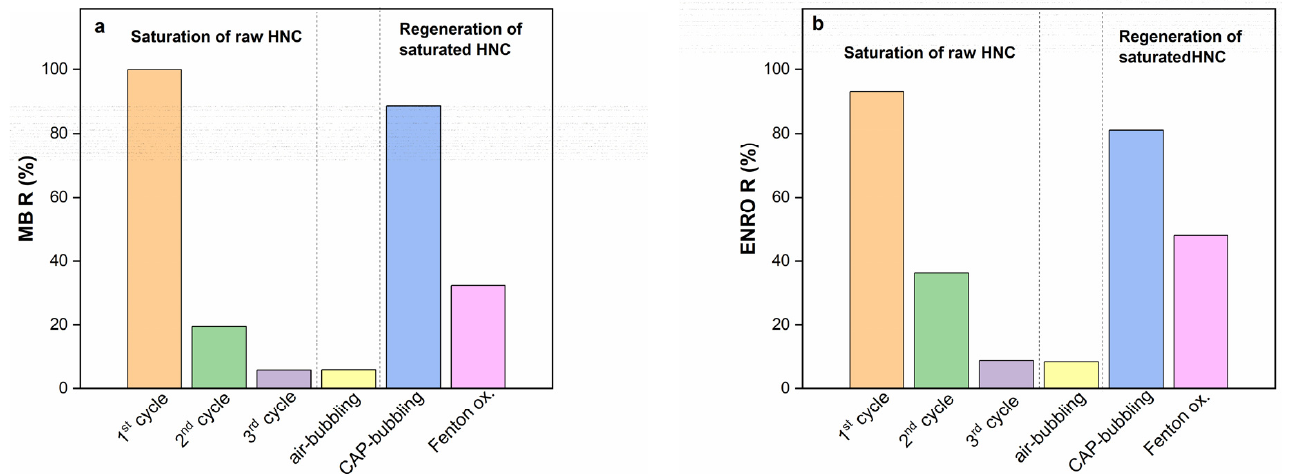
Figure 9. Removal efficiency for ( a ) MB and ( b ) ENRO after three adsorption cycles and regeneration of saturated HNC by applying air bubbling, CAP bubbling and Fenton oxidation (C ENRO = 40 mg/L, C MB = 40 mg/L, pH = 6.2, C HNC = 2 g/L, T = 28 °C).